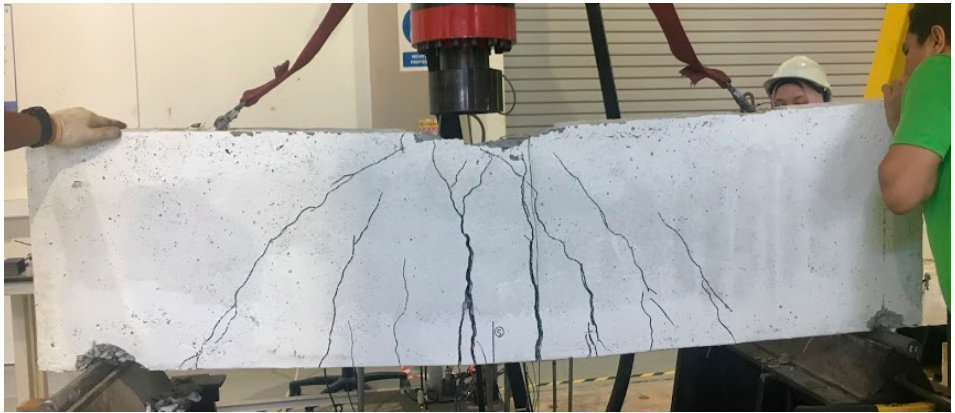
Figure 6. The crack patterns of control beam at failure.